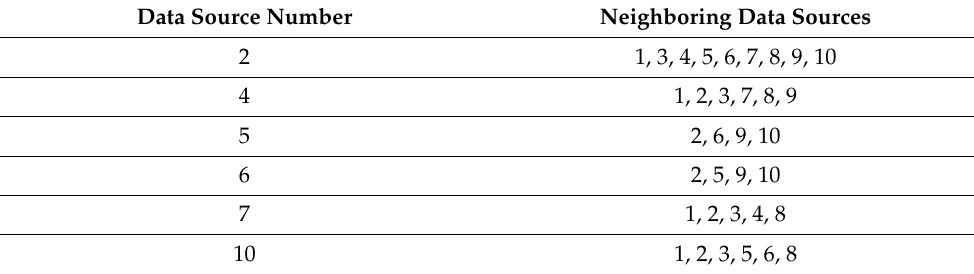
Table 4. List of neighbor nodes of each missing data